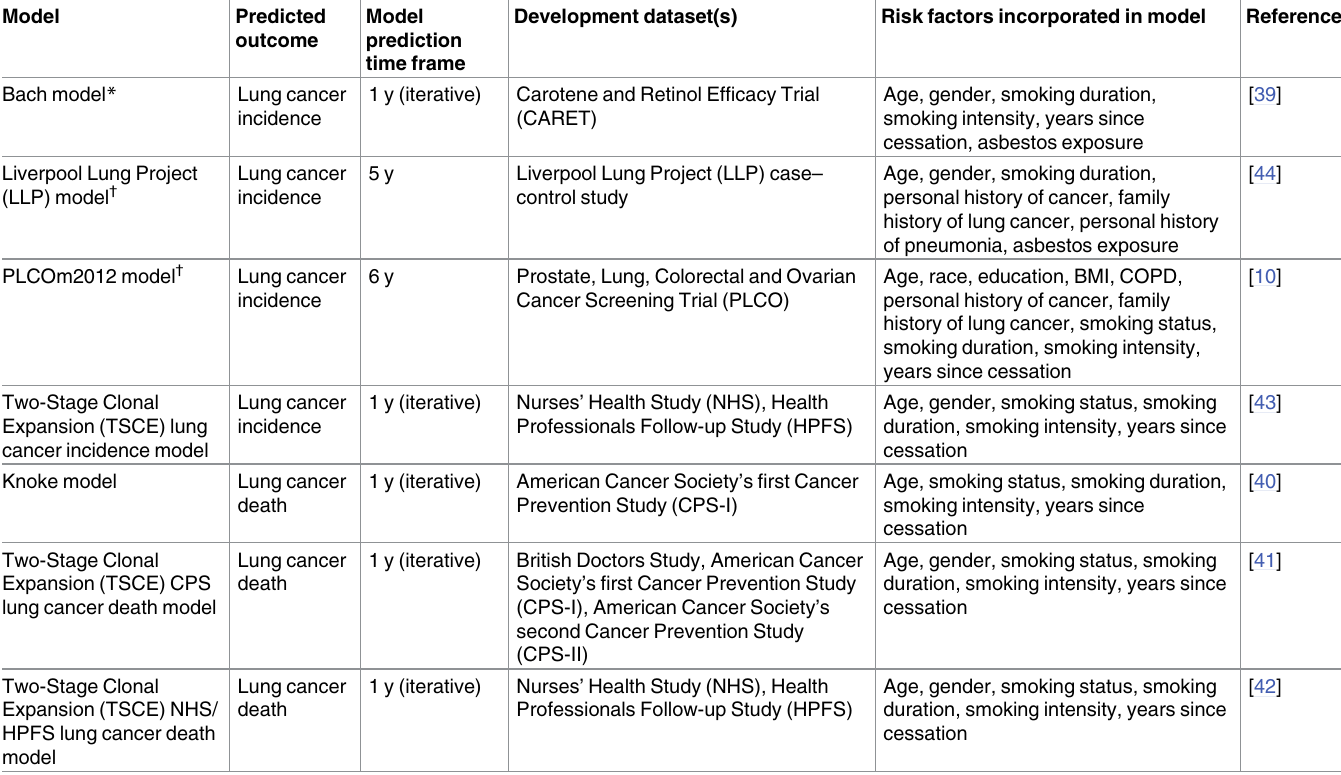
Table 1. Characteristics of investigated risk